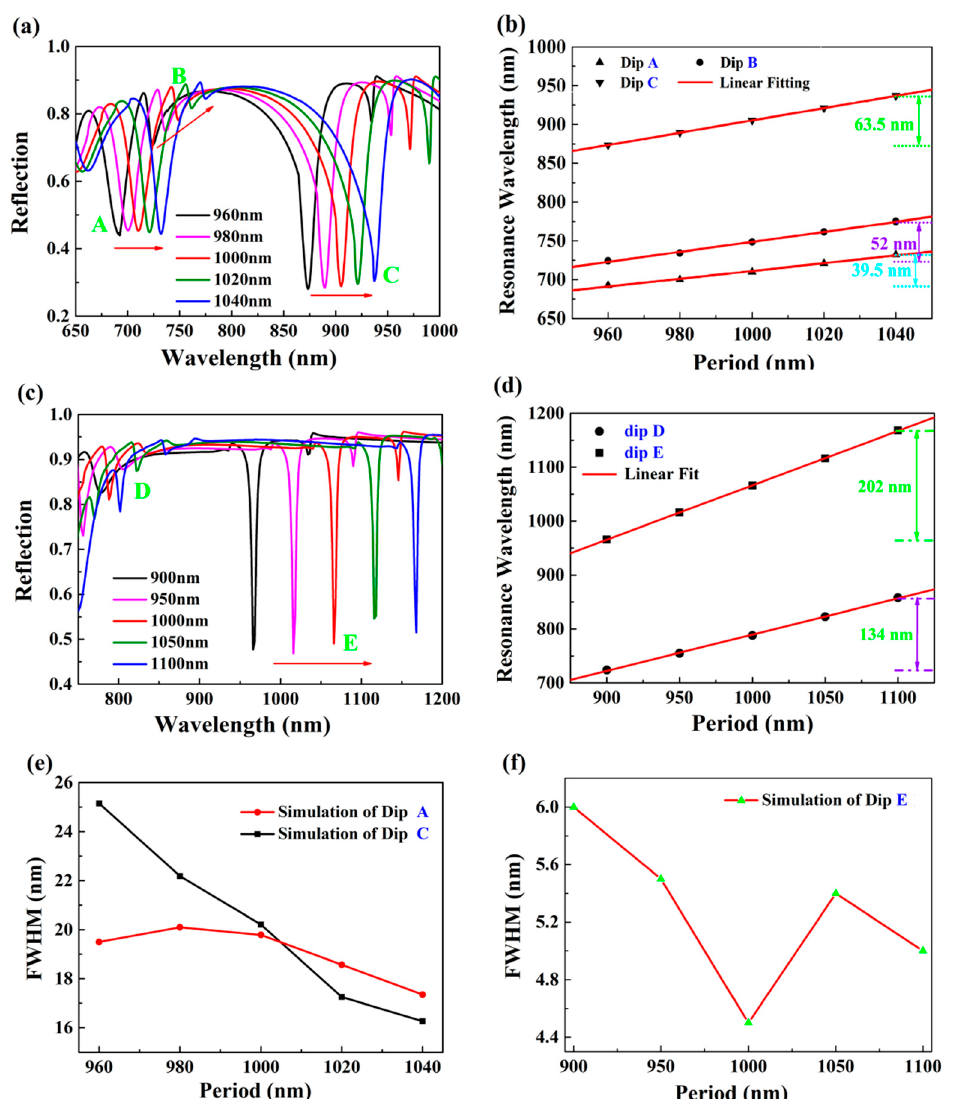
Figure 5. The influence of structural period P on resonant dips. For the case of incident angle 65°, ( a ) reflection spectra, ( b ) the relationship between wavelength position of resonant dips and period P , and ( e ) the effect of period P on line width of dips A and C. For the case of incident angle 30°, ( c ) reflection spectra, ( d ) the relationship between wavelength position of resonant dips and period P , and ( f ) the effect of period P on line width of dip E.